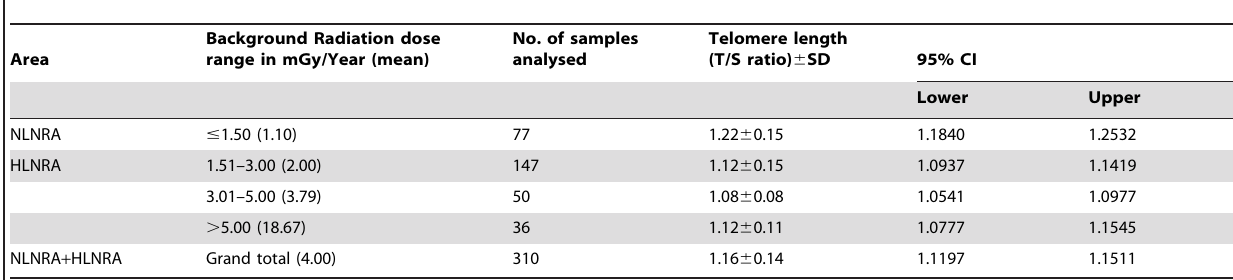
Table 1. Telomere length in various background dose levels and 95% Confidence Intervals (CI).